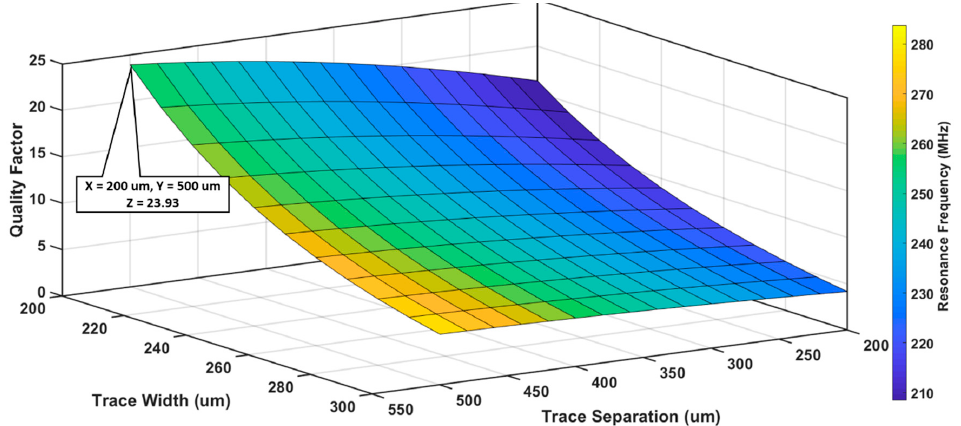
Figure 9. S 2 quality factor and resonance frequency analysis for different trace separation and trace width when the number of turns and outer diameter were 5 and 12 mm, respectively.